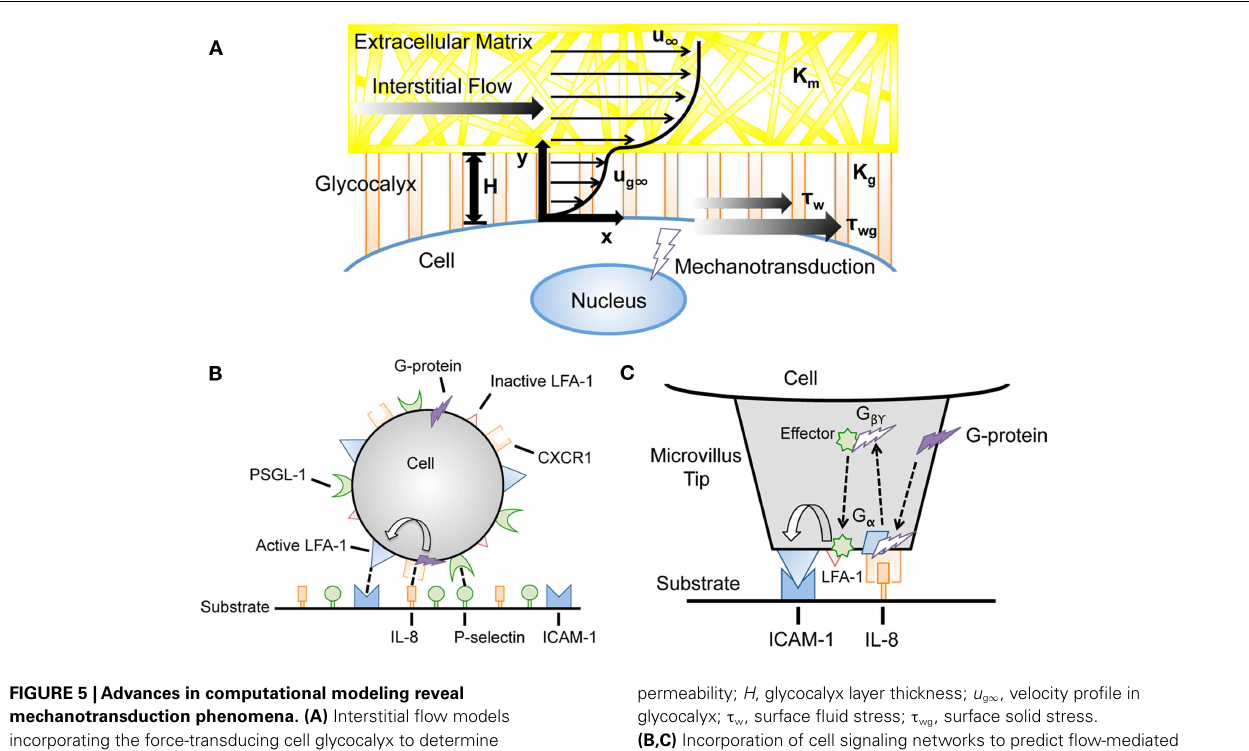
FIGURE 5 |Advances in computational modeling reveal mechanotransduction phenomena. (A) Interstitial flow models incorporating the force-transducing cell glycocalyx to determine interstitial flow contributions to fluid shear stress-dependent mechanotransduction (Tarbell and Shi, 2012). u ∞ , velocity far from cell surface; K m , matrix Darcy permeability; K g , glycocalyx